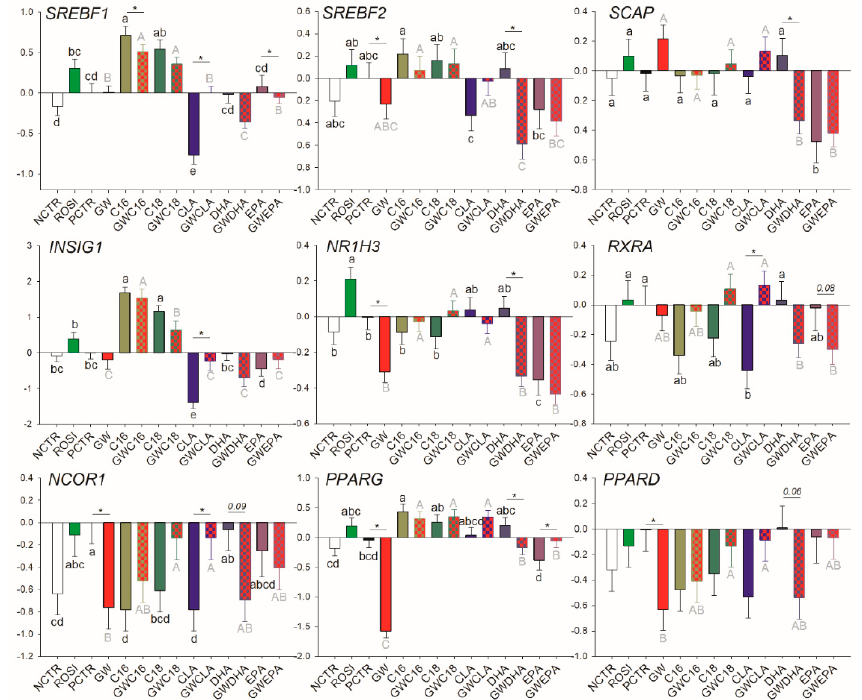
Figure 3. Effect of LCFA (palmitic acid [C16], stearic acid [C18], trans10, cis12 conjugated linoleic acid [CLA], docosahexaenoic acid [DHA], and eicosapentaenoic acid [EPA]), PPAR γ agonist (ROSI; rosiglitazone) and LCFA + PPAR γ antagonist (GW; GW9662) on transcription of genes involved in transcriptional regulation of lipogenesis. Lower case letters and uppercase letters denote statistical differences ( p < 0.05) between treatments without GW and treatments with GW, respectively. * denotes statistical difference ( p < 0.05) between presence and absence of GW in the same LCFA treatment. For GW treatment alone, * denotes statistical difference ( p < 0.05) with the PCTR.